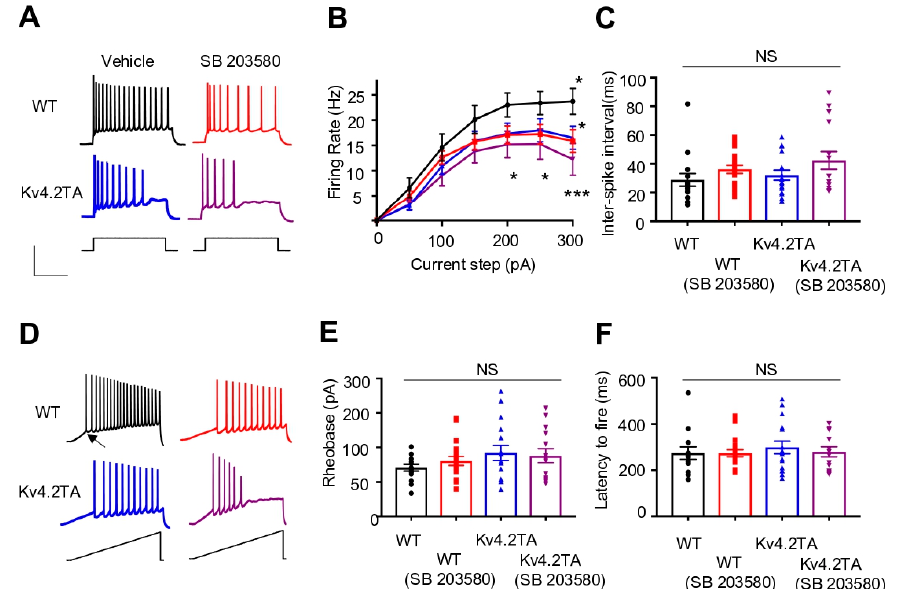
or without SB 203580, although a modest, but non-statistically significant, increase in AP threshold and rheobase was observed in slices from WT mice with pharmacological p38 blockade (Table 1 and Figure 6E).